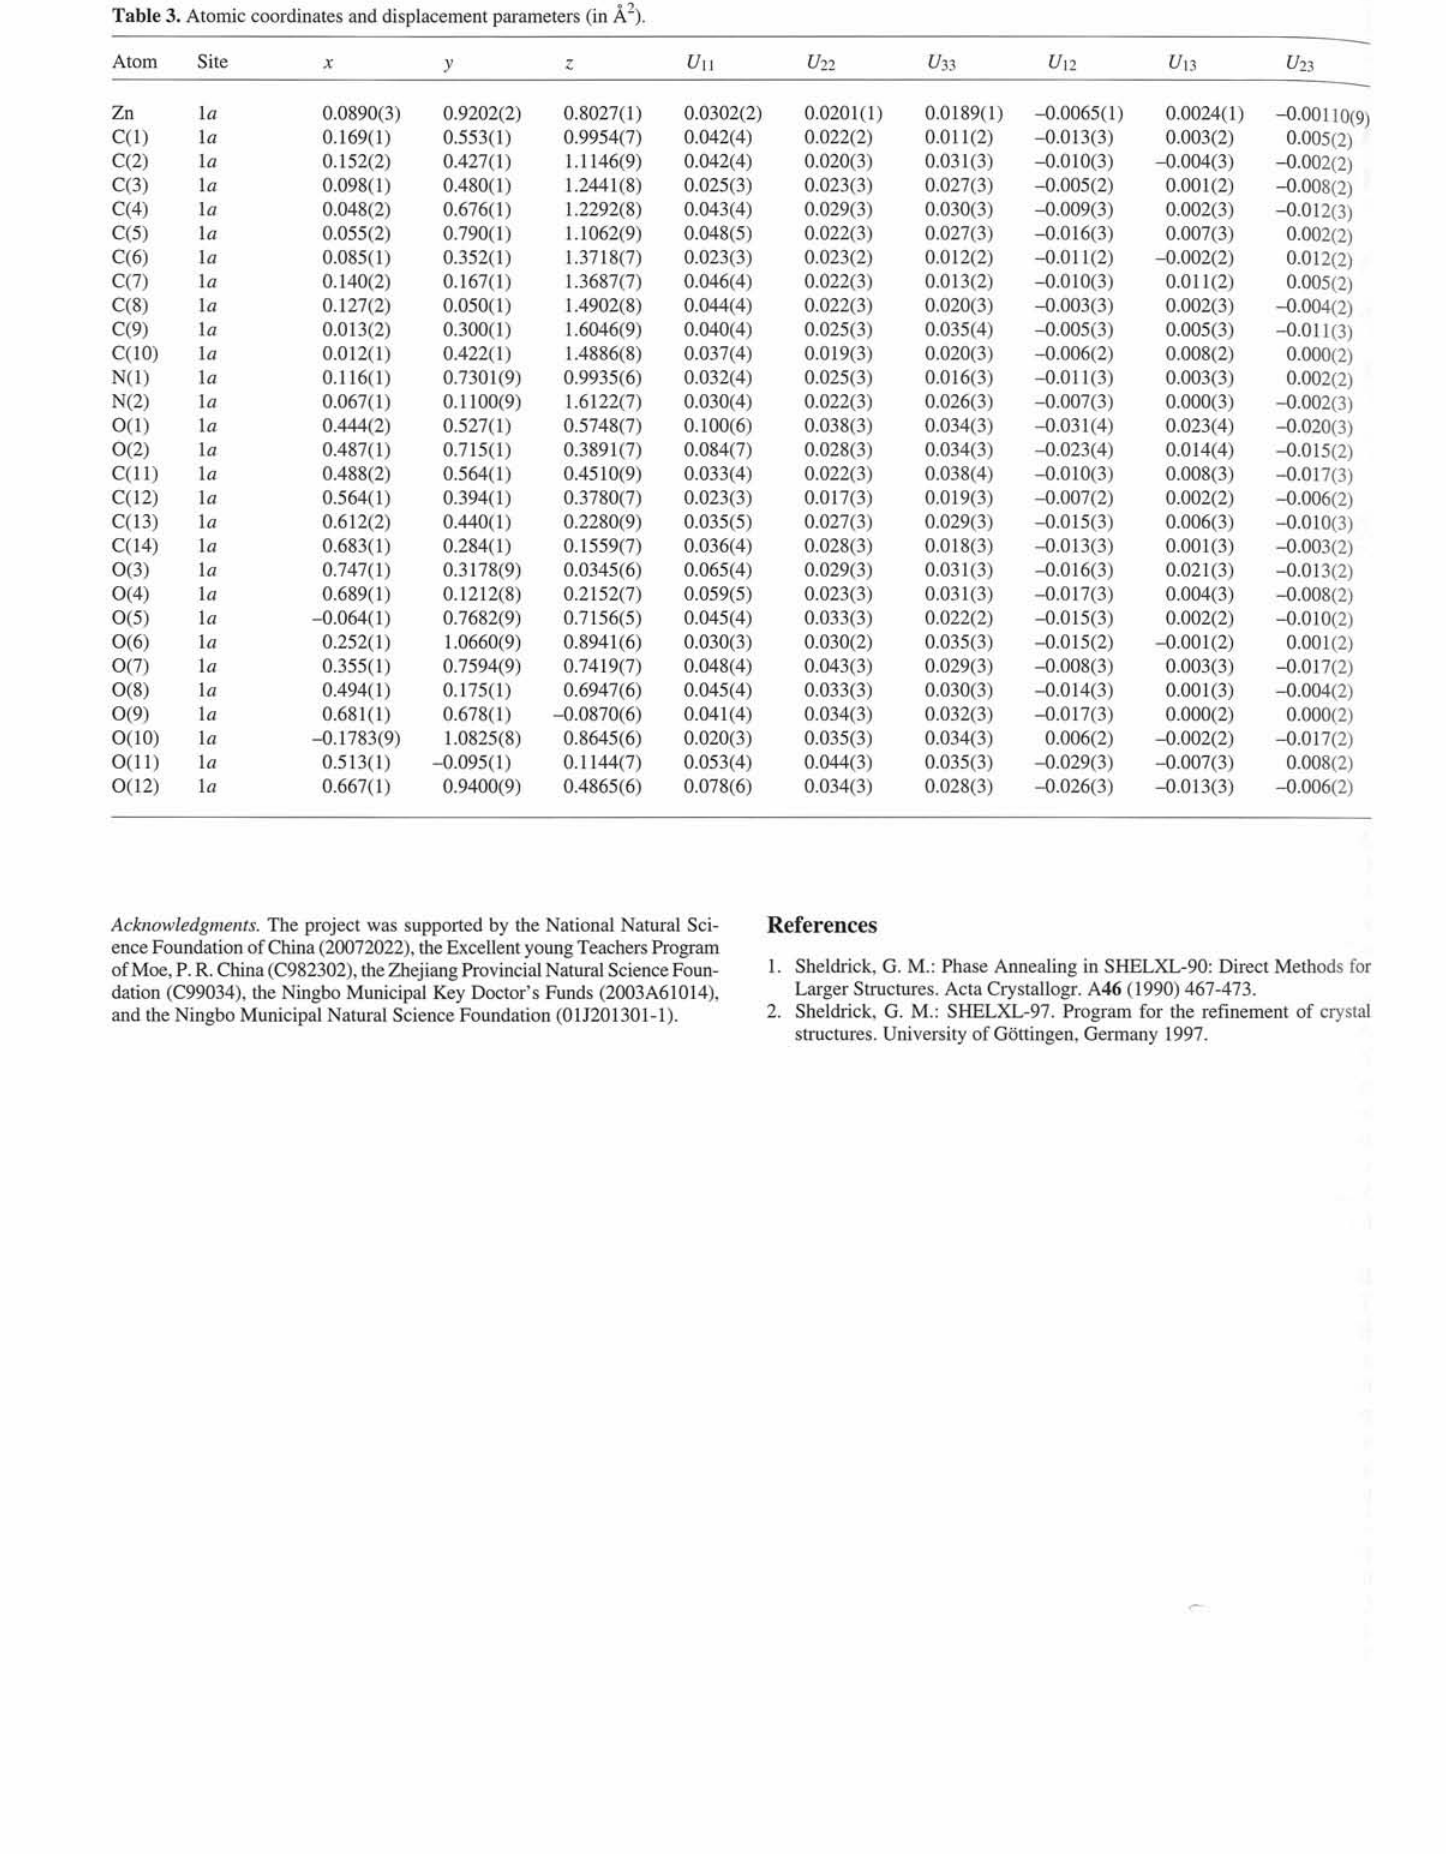
Table 3. Atomic coordinates and displacement parameters (in Â 2